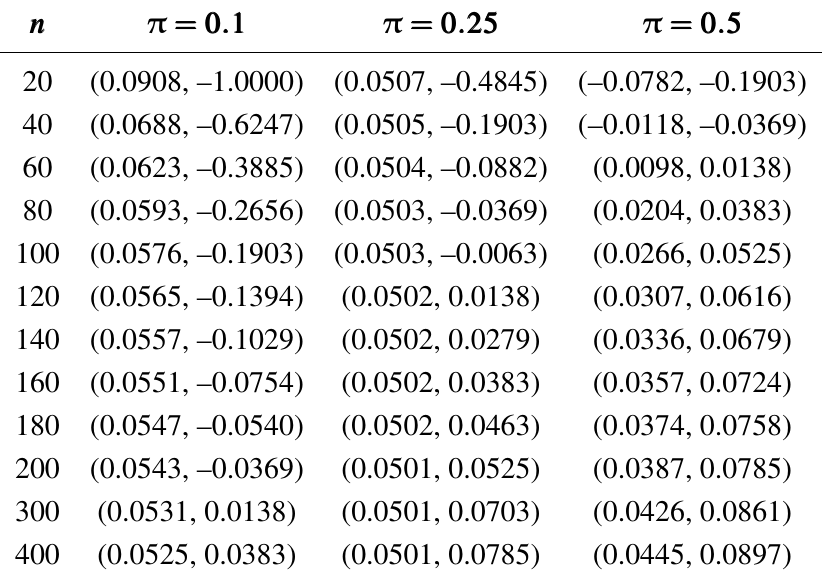
) in case of a predictive prior, i.e. ; c (cid:3) 1 0